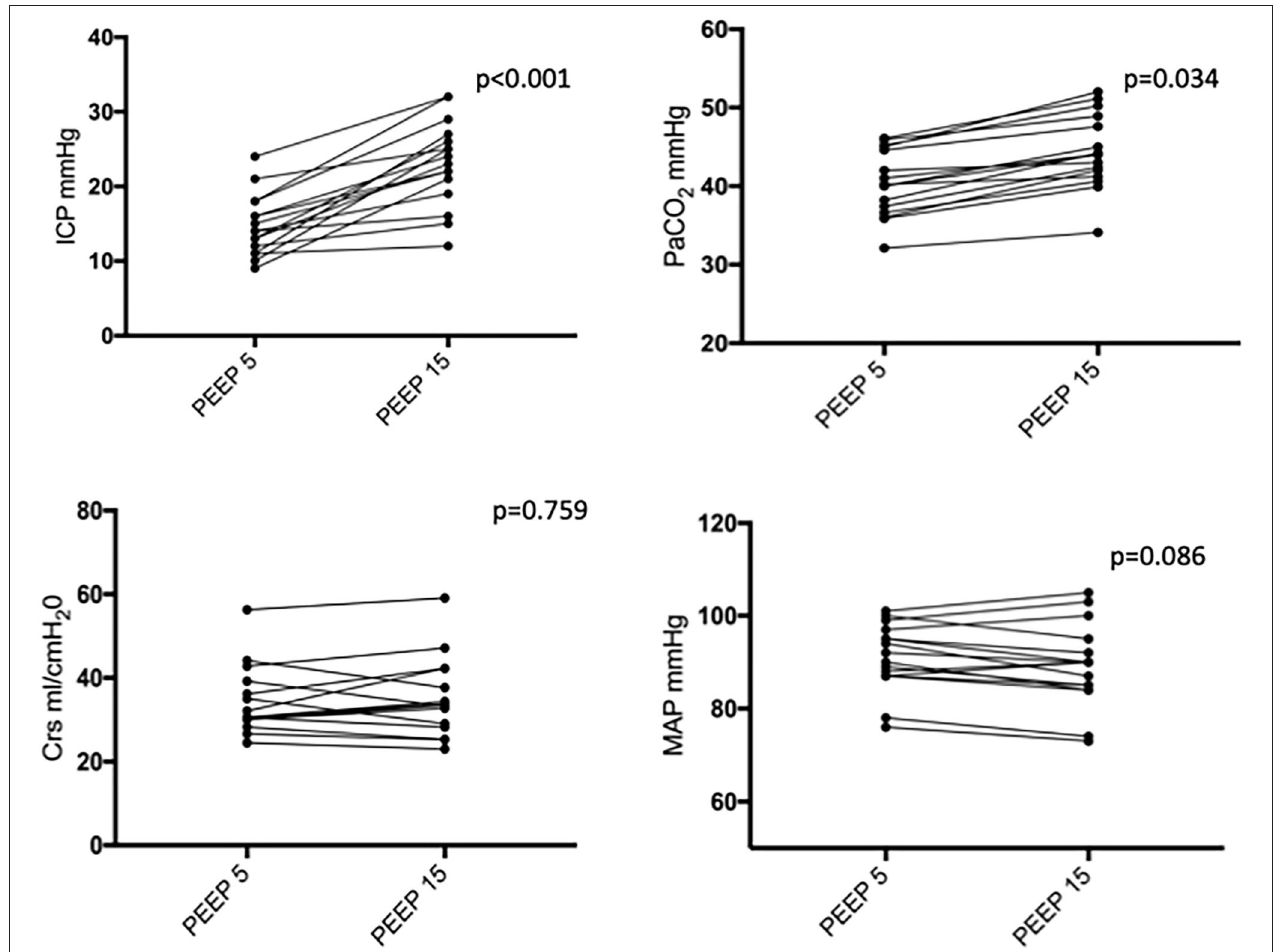
FIGURE 2 | Intracranial pressure (ICP), partial pressure of carbon dioxide (PaCO 2 ), respiratory system compliance (Crs), and mean arterial pressure (MAP) at PEEP of 5 and 15 cmH 2 O. Black dots and lines represent individual patient data. PEEP, positive end-expiratory